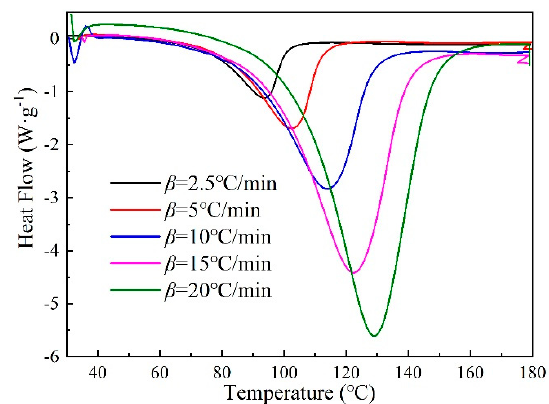
Figure 1. The di ff erential scanning calorimetry (DSC) curves of AG-80 / m-xylylenediamine (m-XDA) Figure 1. The differential scanning calorimetry (DSC) curves of AG-80/m-xylylenediamine (m-XDA) curing system at di ff erent heating rates ( β = 2.5, 5, 10, 15, and 20 ◦ C · min − 1 ) in N 2 atmosphere curing system at different heating rates ( β = 2.5, 5, 10, 15, and 20 °C·min − 1 ) in N 2 atmosphere [37].